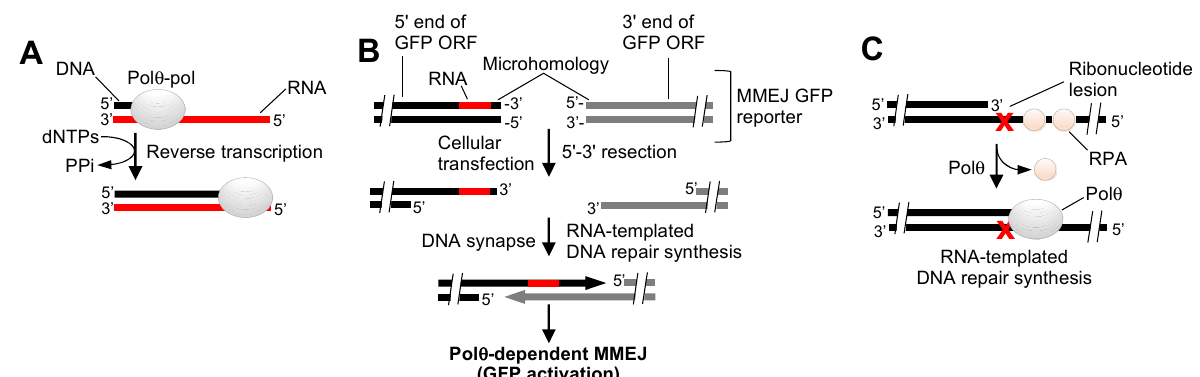
Figure 5. Pol θ -pol RNA-dependent DNA synthesis activities. ( A ) Pol θ -pol reverse transcribes RNA, similar to retroviral reverse transcriptases. ( B ) Schematic of an MMEJ GFP DNA reporter construct used to detect Pol θ RNA-templated DNA repair synthesis in cells. ( C ) Model of Pol θ TLS opposite a ribonucleotide lesion.